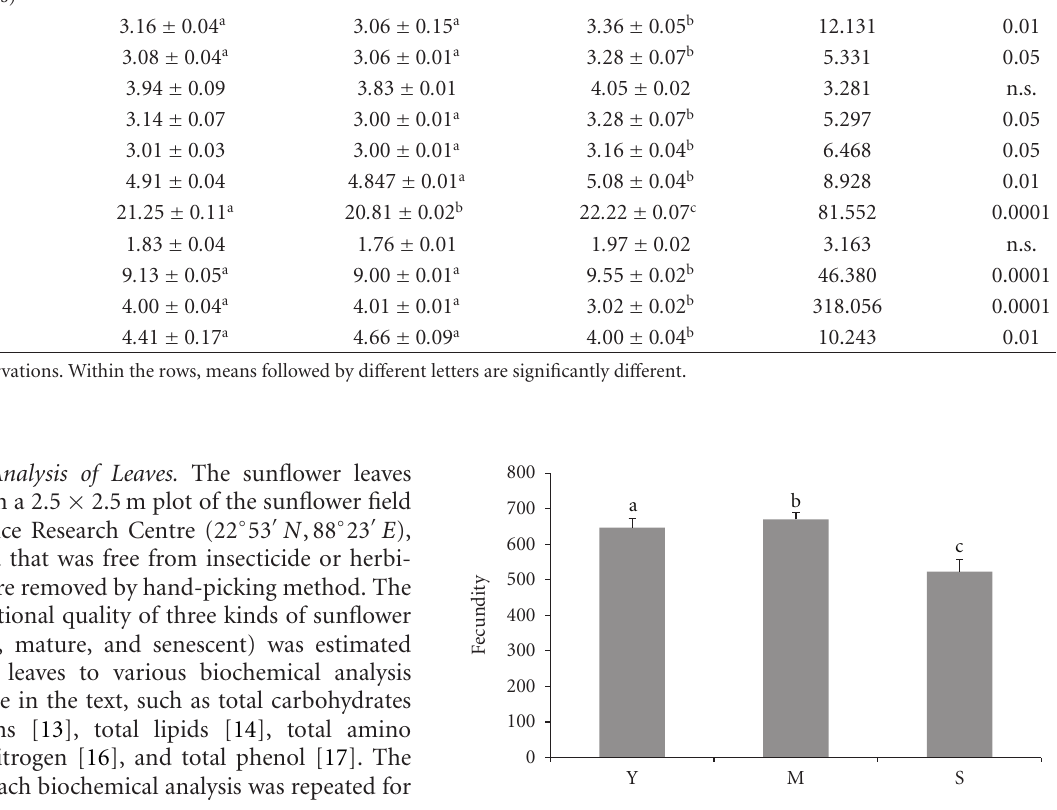
Figure 1: Total eggs per female D. casignetum on young (Y), mature (M), and senescent (S) sunflower leaves. Means ± SE of five observations. The di ff erent letters over the three bars indicate that the means are significantly di ff erent at P <